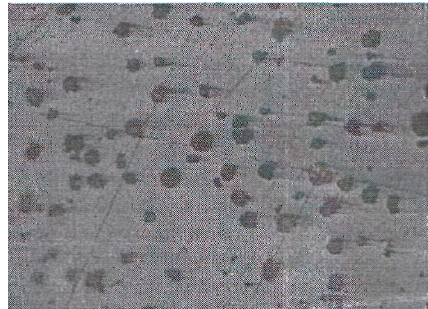
Figure 1. Typical structure of nodular cast iron.